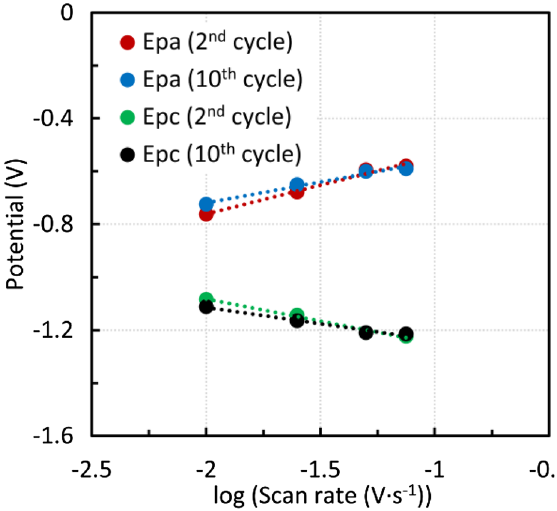
Figure 15. Effect of the scan rate on the position of the peak potentials, sludge